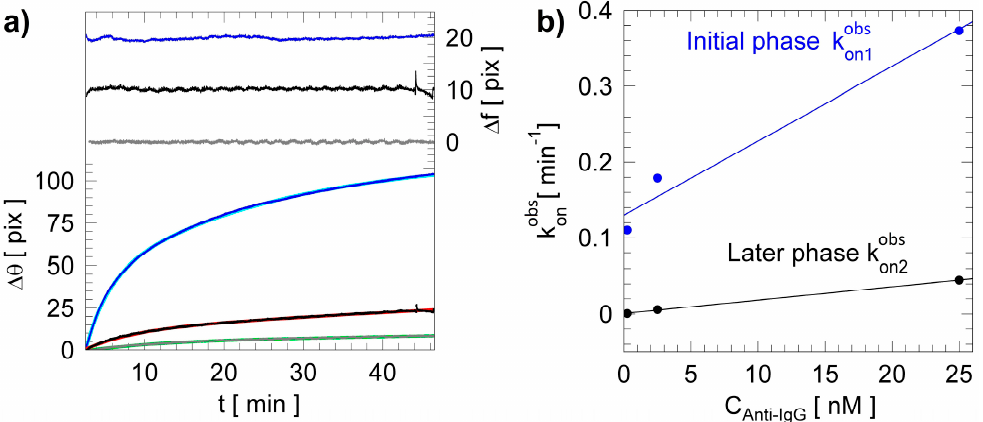
Figure 6. ( a ) Association binding curves for increasing concentration of Anti ‐ IgG. On the right axis difference ( ∆ f) between the biphasic fitting model (cyan, red and green) and experimental data (blue, black and gray), respectively, for 25 nM, 2.5 nM and 0.25 nM; ( b ) observed on-rate constants k obs and k obs for the initial (blue) and later (black) phases as a function of C Anti-IgG . From the curve fits, it is possible to extract, for the initial and delayed interaction phase, k ass 1 = (1.60 ± 0.28) ∙ 10 5 [M] − 1 [s] − 1 , k diss 1 = (2.16 ± 4.16) ∙ 10 − 4 [s] − 1 and k ass 2 = (0.28 ± 0.0065) ∙ 10 5 [M] − 1 [s] − 1 , k diss 2 = (0.13 ± 0.009) ∙ 10 − 4 [s] − 1 , respectively. The determination of both k ass and k diss allows the calculation of